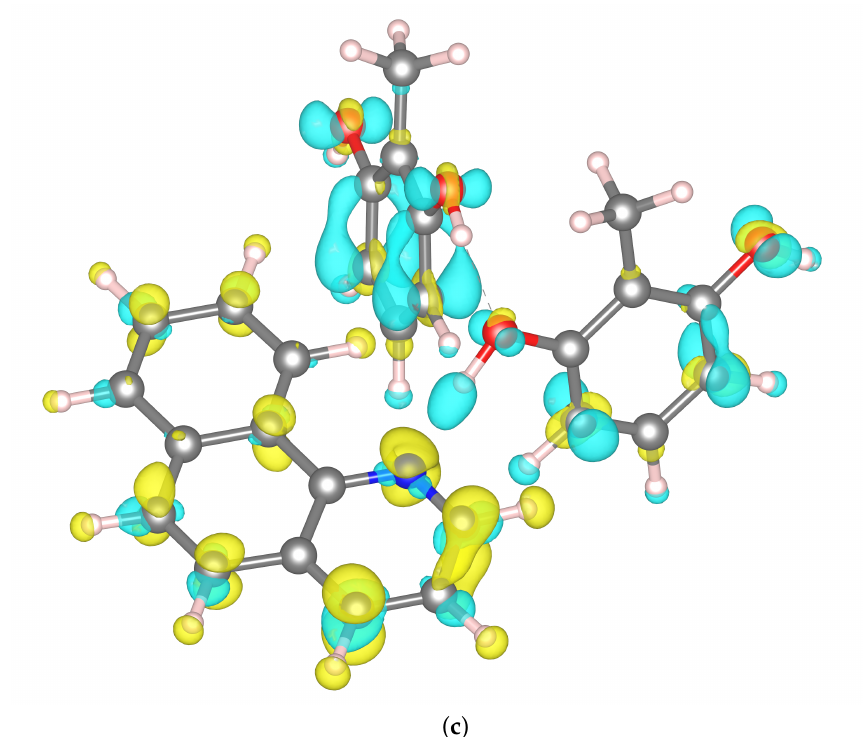
Figure 8. The differences in charge density calculated for the constrained electron transfer to the benzo[h]quinoline-2-methylresorcinol complexes: ( a ) dimer, ( b ) trimer 1, and ( c ) trimer 2. The yellow and blue areas represent the areas of the increased and decreased charge density, respectively. The isosurfaces are drawn for the value of